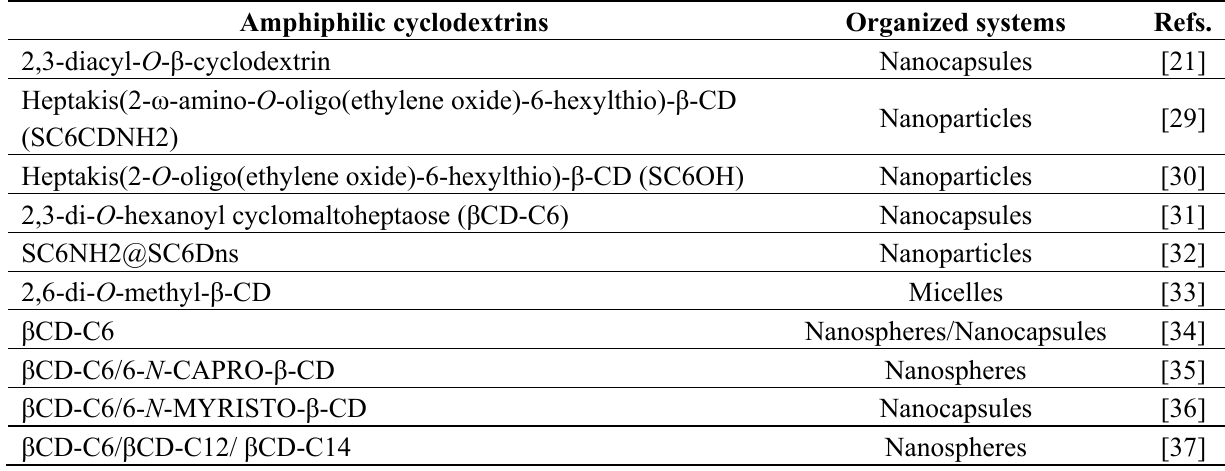
Table 1. Nanosystems formed by self-assembly of amphiphilic cyclodextrins. Amphiphilic